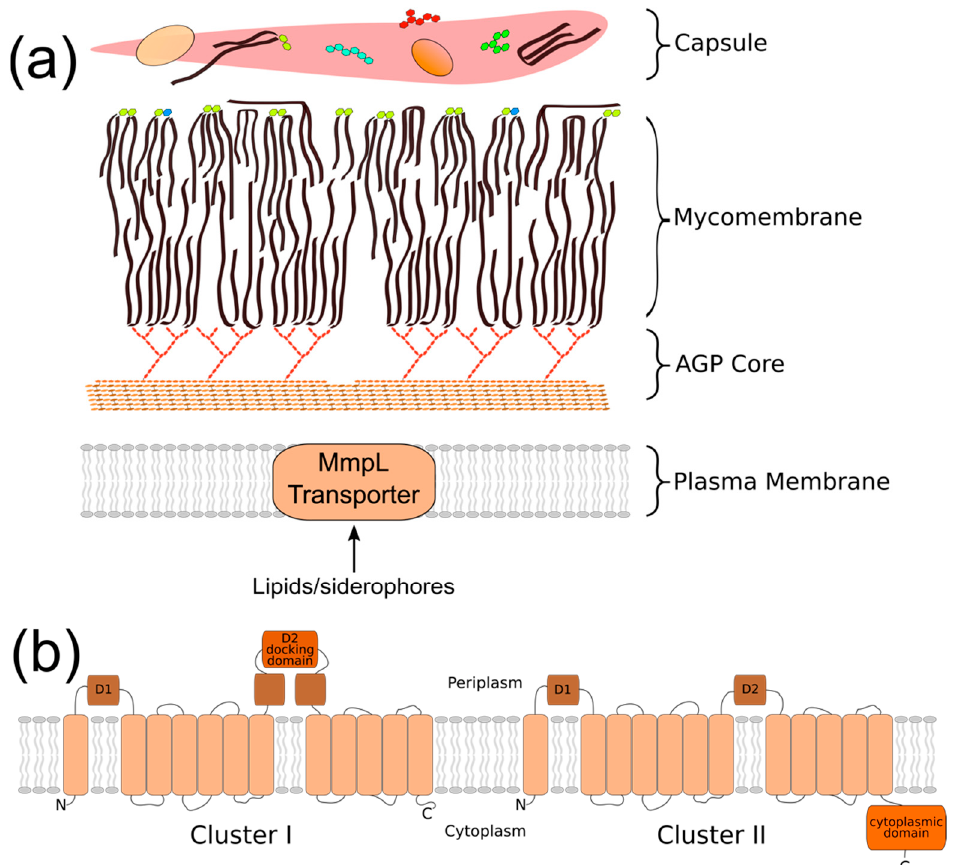
Figure 1. Mycobacterial membrane protein large (MmpL) proteins are topologically complex membrane proteins that export cell envelope components across the plasma membrane. ( a ) Cartoon representation of the mycobacterial cell envelope; ( b ) M. tuberculosis ( Mtb ) MmpL can be classified into two clusters based on the complexity of the D2 periplasmic domain and the presence of a cytoplasmic C-terminal domain. Cluster I = MmpL1/2/4/5/6/7/8/9/10/12; cluster II = MmpL3/11/13a/b. Other species of mycobacteria harbor different numbers of MmpL